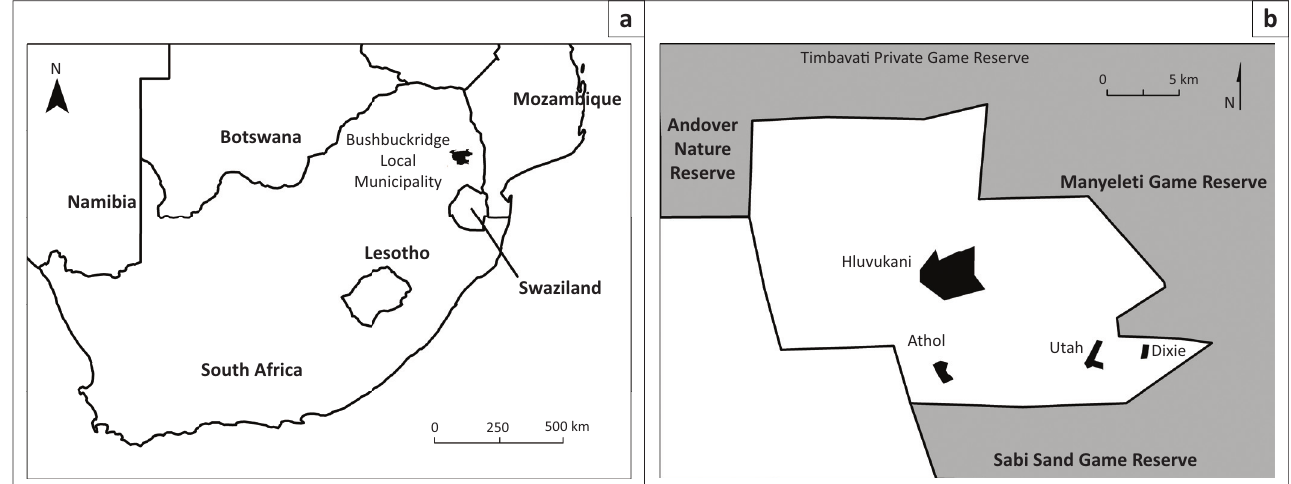
FIGURE 1: (a) Location of Bushbuckridge Local Municipality in South Africa and (b) location of Hluvukani, Athol, Utah and Dixie villages in the Mnisi Tribal Authority area and proximity of game